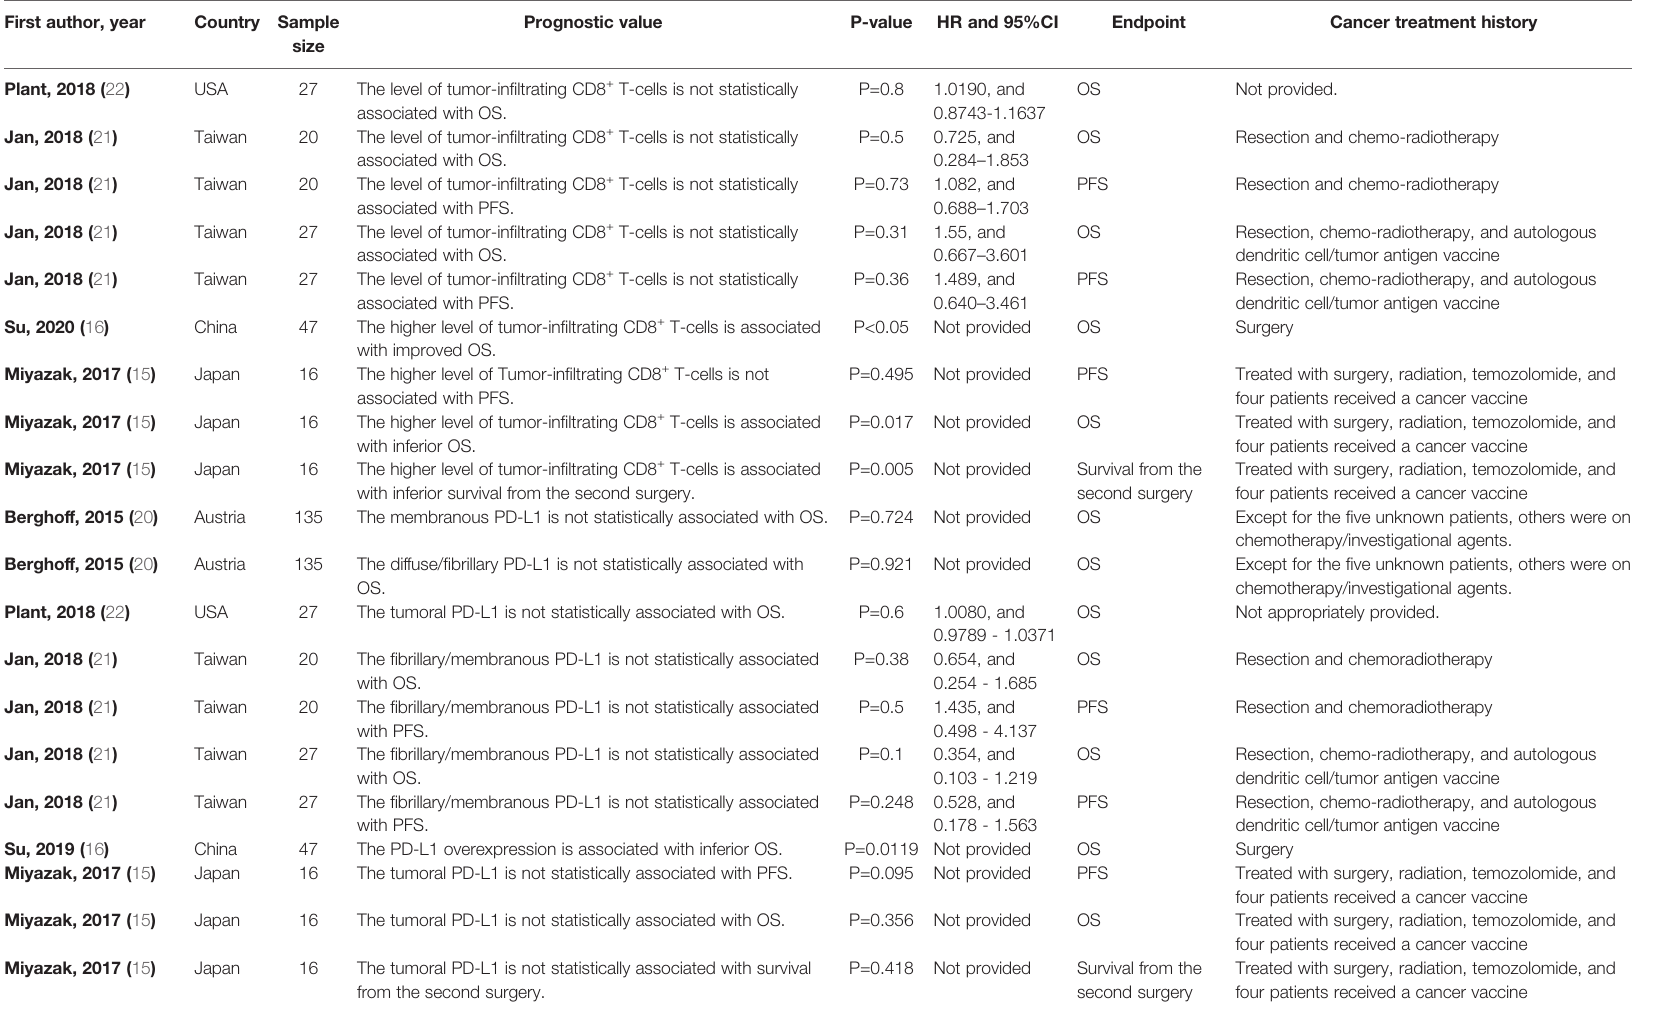
TABLE 3 | The prognostic value of tumor-in fi ltrating CD8 + T-cells/PD-L1 axis in high-grade glioma